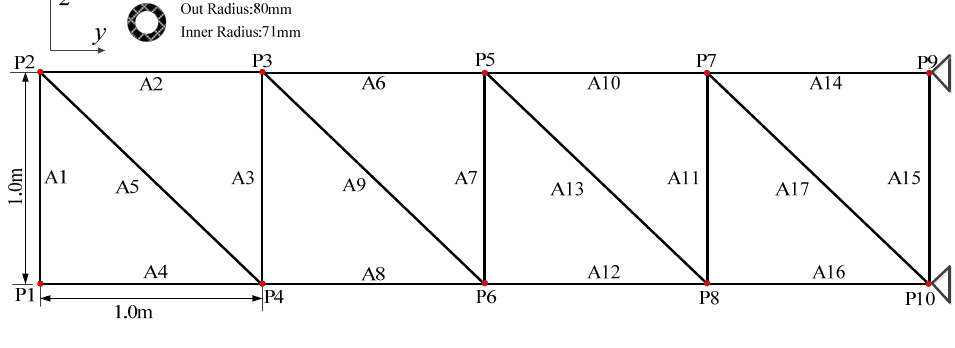
Figure 6. Scheme periodic frame structure.